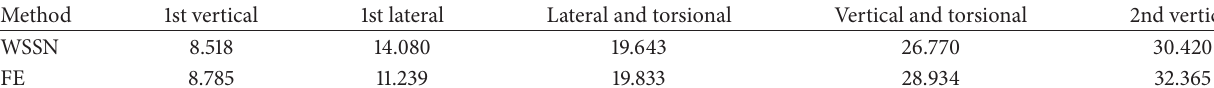
Table 5: FDD frequency identification compared to FE modal analysis.